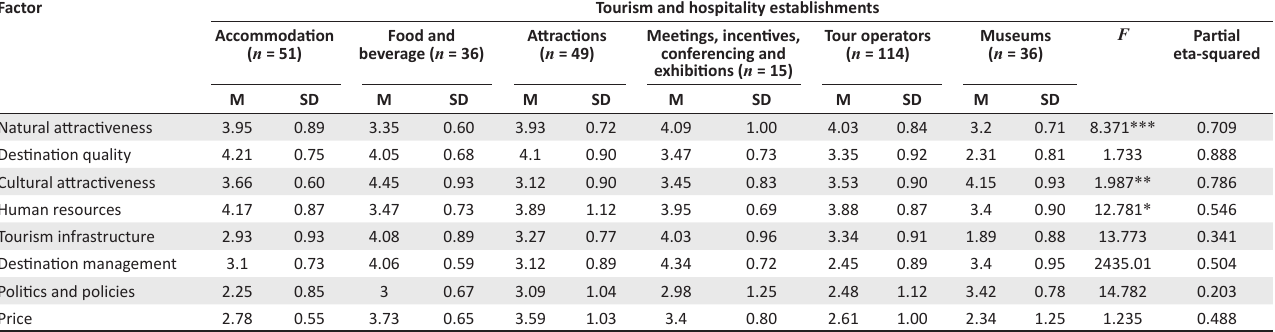
TABLE 4: Results of multivariate analysis of variance.